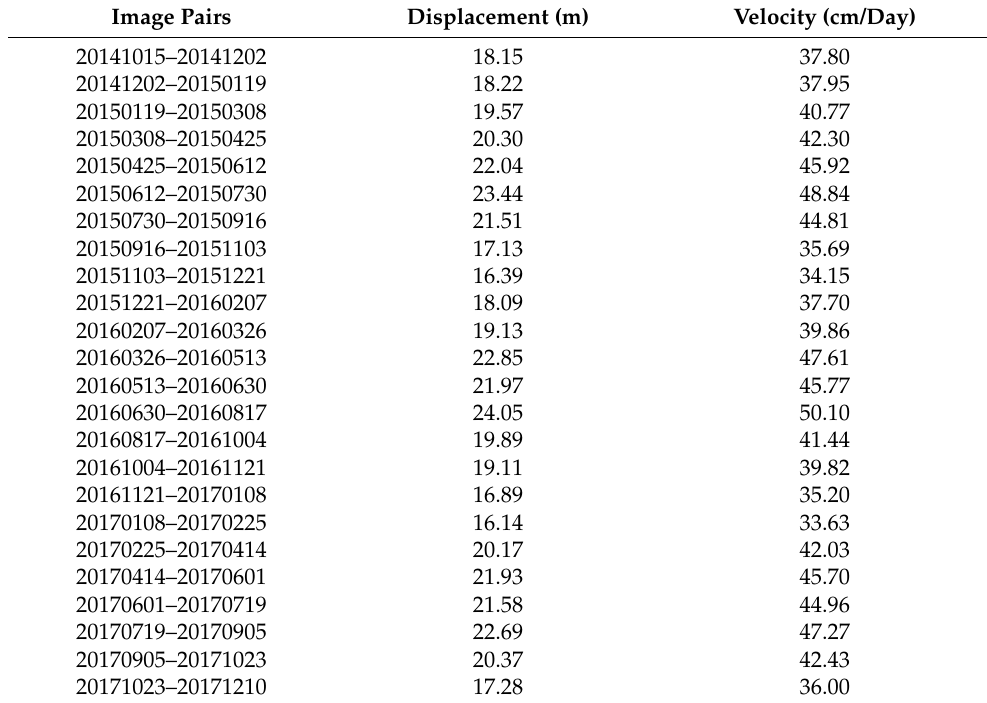
Table 2. Surface displacement and mean velocity of the Yiga Glacier.